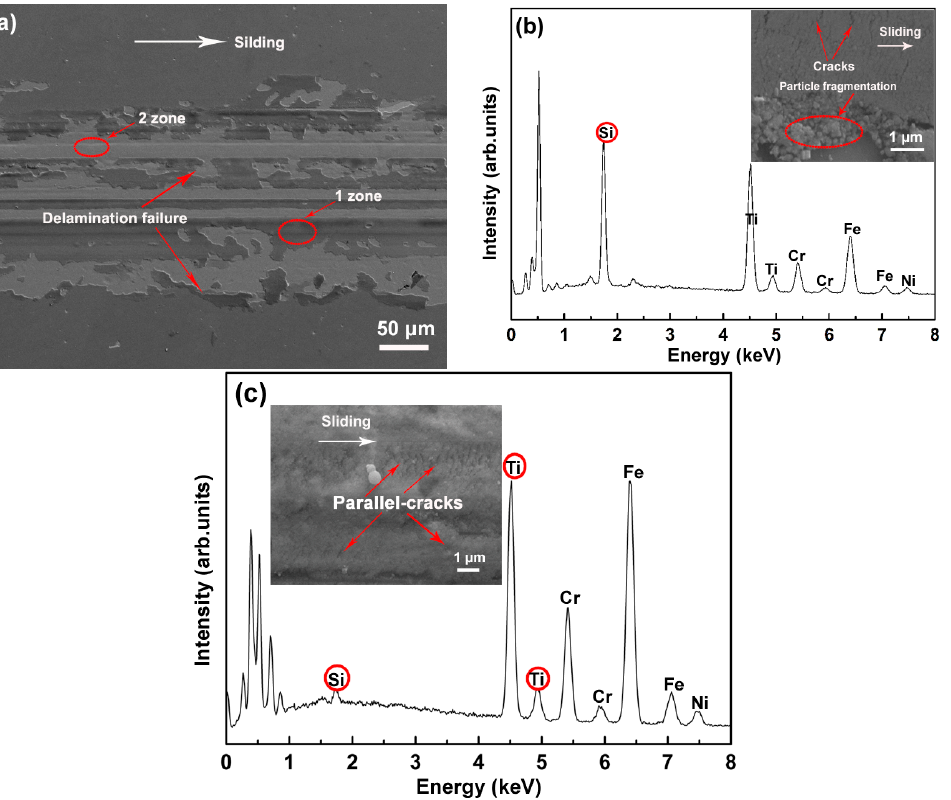
Figure 10. ( a ) SEM wear track image of the TiN/SiO x duplex coating in air; ( b ) EDS analysis of zone 1; ( c ) EDS analysis of zone 2.